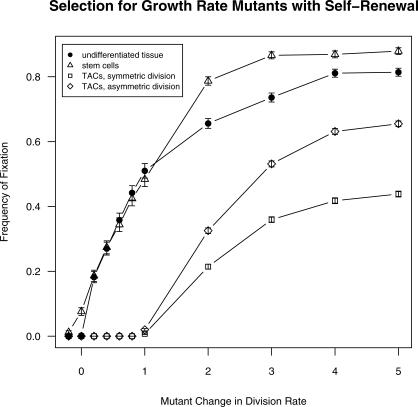
Frequency of Fixation by Mutations Affecting Cell Division in Nondifferentiating Populations, Under Serial Differentiation with Self-Renewal (n = 4 Non-Stem Stages) for Stem Cells, Transient Amplifying Stages Dividing Symmetrically, and Transient Amplifying Stages Dividing AsymmetricallyEach data point represents at least 500 trials with standard error bars. Nondifferentiating populations, filled circles; serial differentiation with self-renewal for stem cells, triangles; transient amplifying stages dividing symmetrically, squares; transient amplifying stages dividing asymmetrically, diamonds.